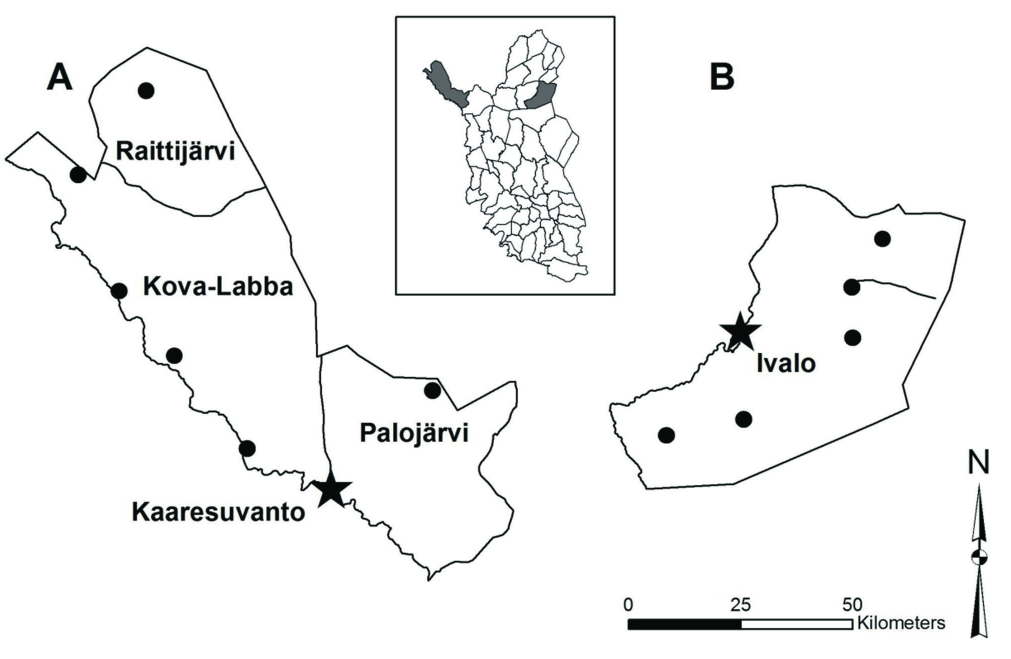
Fig. 1. Study areas within the Finnish reindeer husbandry area. The reindeer-herding cooperative of Ivalo (B) is divided into two herding-groups (Nellim and southern area of Ivalo) and Käsivarsi (A) into three herding-groups (Palojärvi, Kova-Labba and Raittijärvi). Reindeer calves were fitted with radio-collars in different corrals (  ) in 1999-2004. The villages of Ivalo and Kaaresuvanto are marked on the map ( 